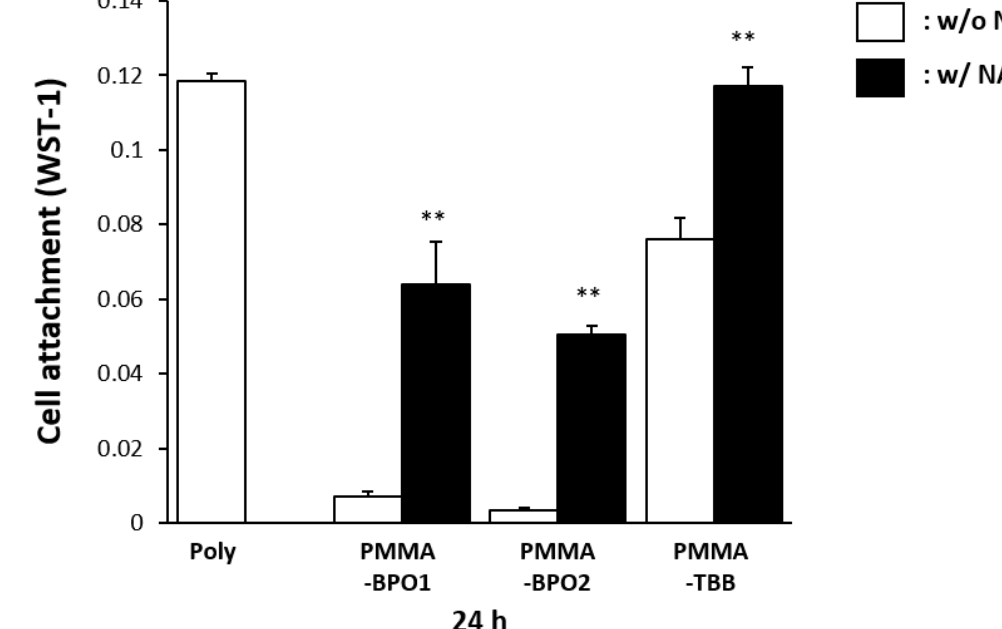
Figure 7. A rescue attempt of three different materials by incorporating the antioxidant amino acid derivative, N-acetyl cysteine (NAC), into the materials examined by the ability of the materials to facilitate cell attachment. The number of osteoblasts attached 24 h after seeding evaluated using WST-1 assay is shown with or without NAC. Each value represents the mean ± standard deviation of triplicate experiments ( n = 3). ** p < 0.01, Welch’s t-test.